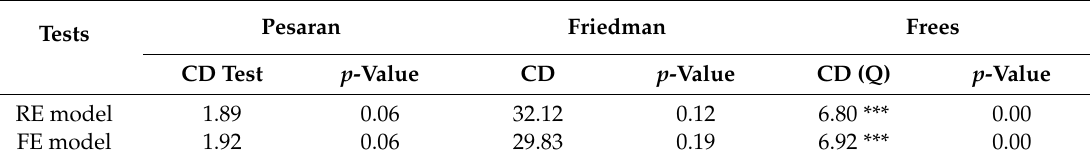
Table 3. Sectional independence tests.